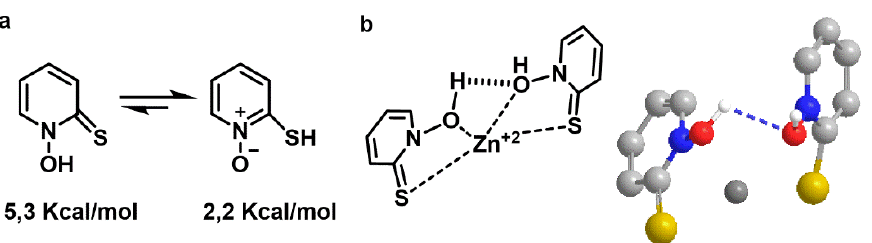
Figure 1. Energy content of the two structures of free pyrithione ( a ). Binding sites and spatial orientation with zinc cations ( b ). Light grey balls represent carbon atoms. Blue balls represent nitrogen atoms. Non linked dark grey balls represent zinc cations. Red balls represent oxygen atoms. Yellow balls represent sulfur atoms.